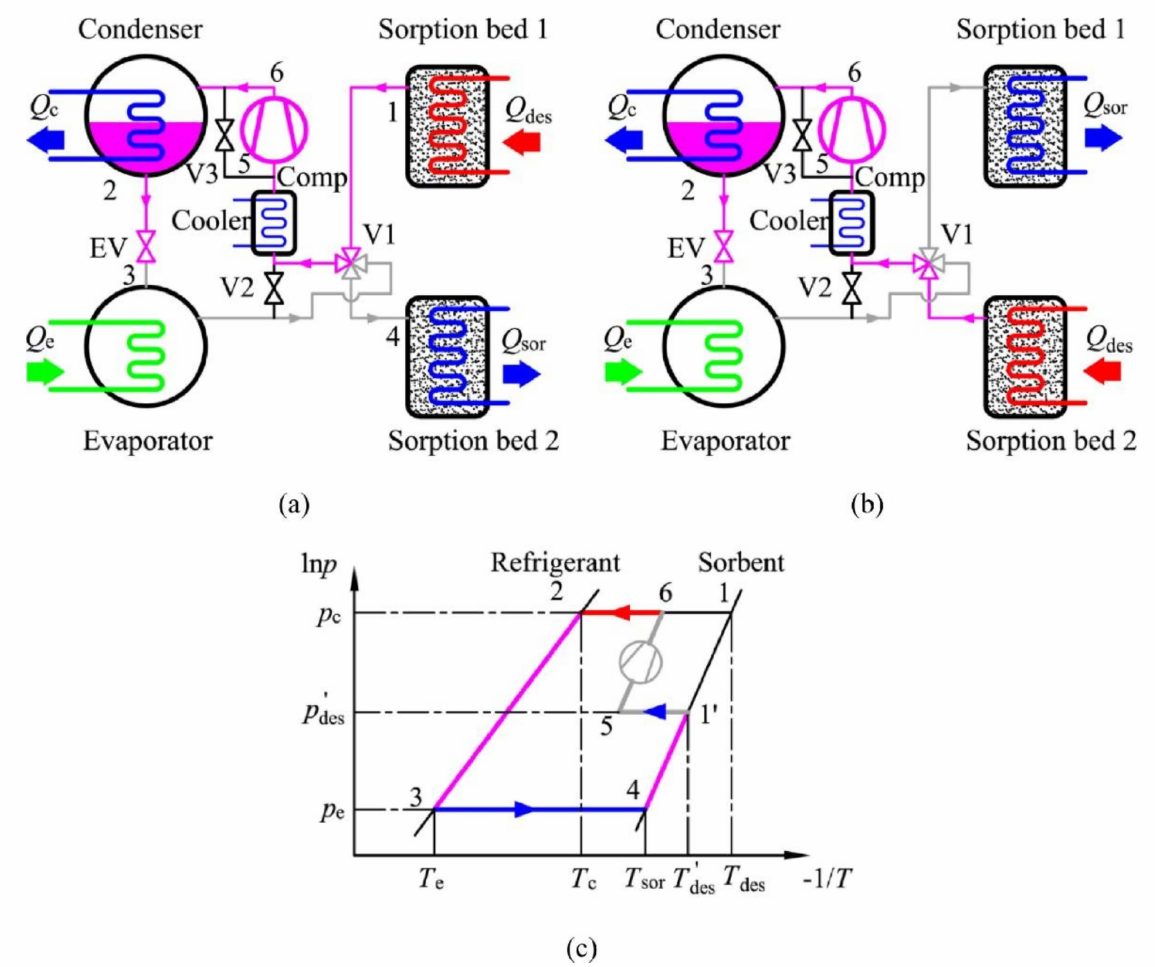
Figure 21. Hybrid solid sorption-compression refrigeration cycle: ( a ) Decomposition process (sorption bed 1) synthesis process (sorption bed 2); ( b ) Synthesis process (sorption bed 1) and decomposition process (sorption bed 2); ( c ) lnP-T diagram. Reprinted from ref. [61], Copyright (2020), with permission from